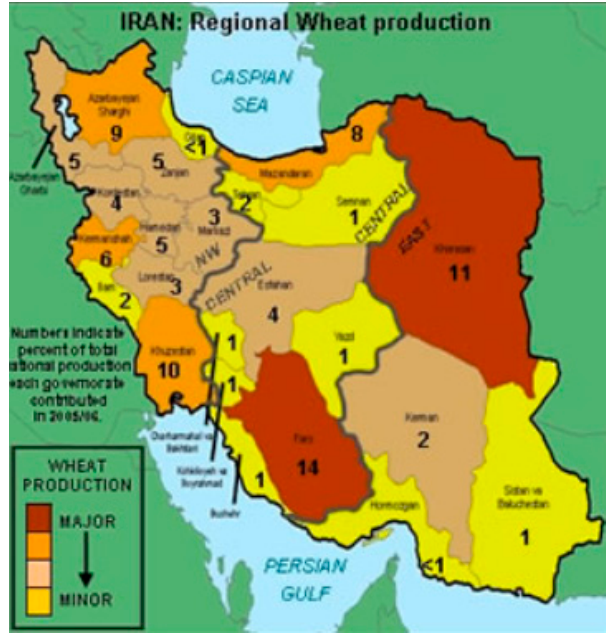
Figure 1. Information about the agricultural land and wheat growing location in Iran.